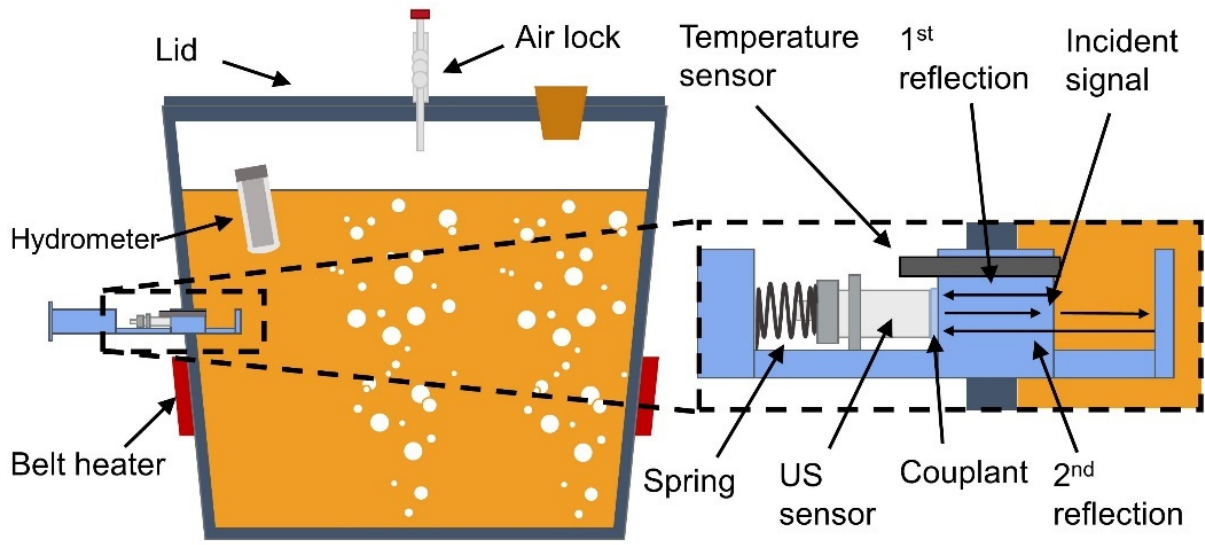
Figure 1. Experimental apparatus and measured US wave reflections.